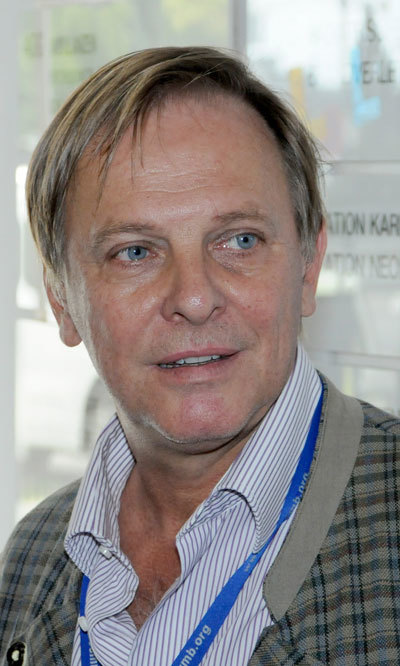
Michael Riccabona